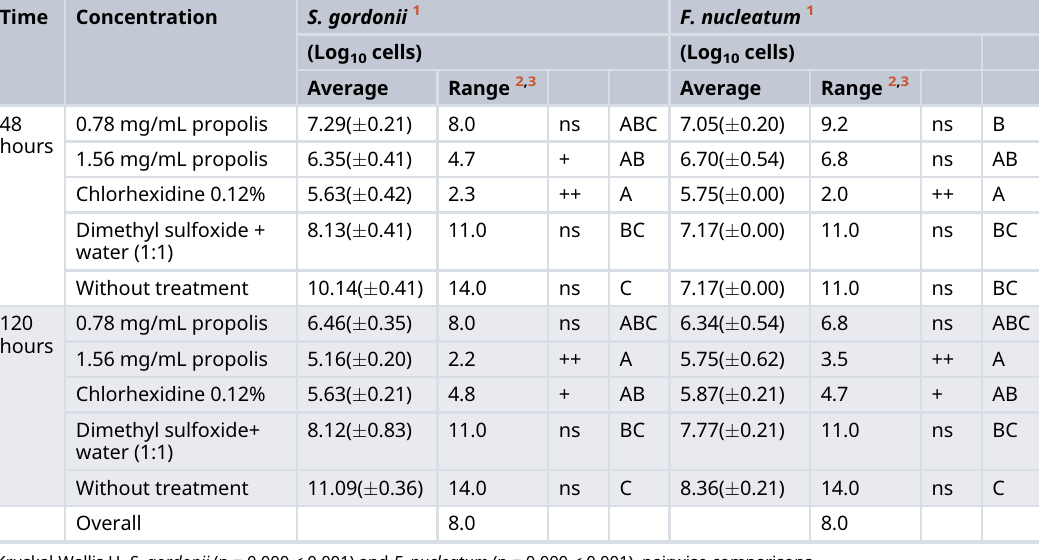
Table 7. Evaluation of the propolis fractions with antibacterial effects against S. gordonii and F. nucleatum according to the amount of bacteria through quantification of the number of copies of the srtA Gene of S.gordonii andthenumberofcopiesofthe radD genein F.nucleatum